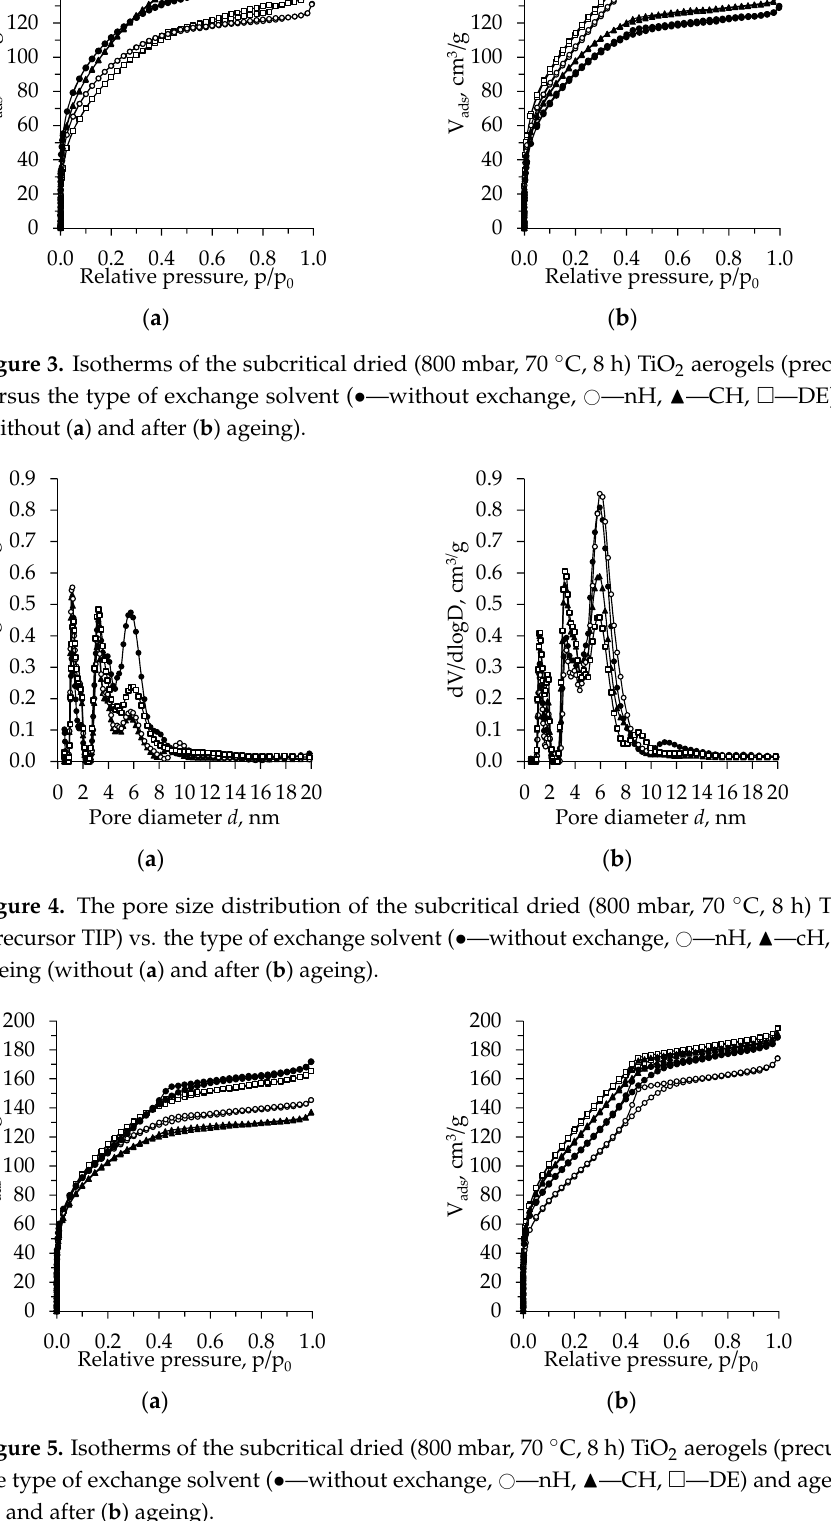
Figure 5. Isotherms of the subcritical dried (800 mbar, 70 °C, 8 h) TiO 2 aerogels (precursor TIP) vs. the type of exchange solvent ( ● —without exchange, ○ —nH, ▲ —CH, □ —DE) and ageing (without ( a ) and after ( b ) ageing).